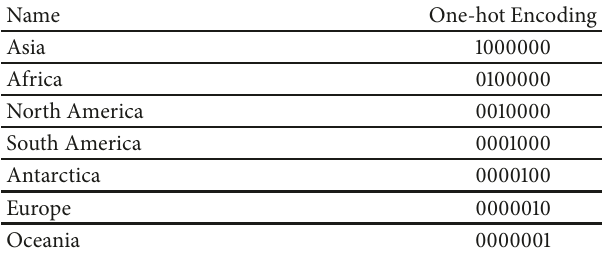
Table 5: One-hot encoding representation of seven continents.